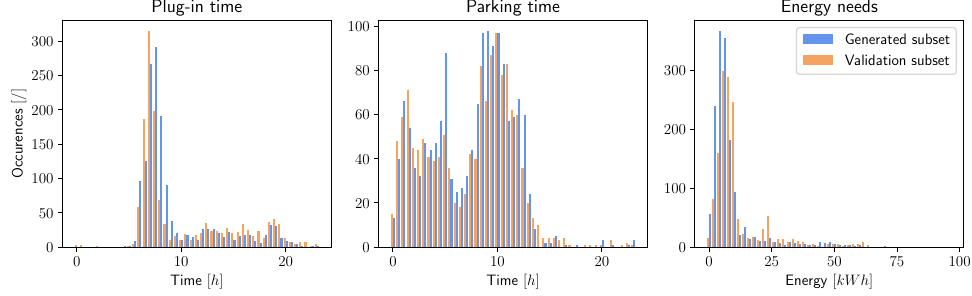
Figure 4. Comparison of plug-in time, parking time and energy needs between generated and real charging